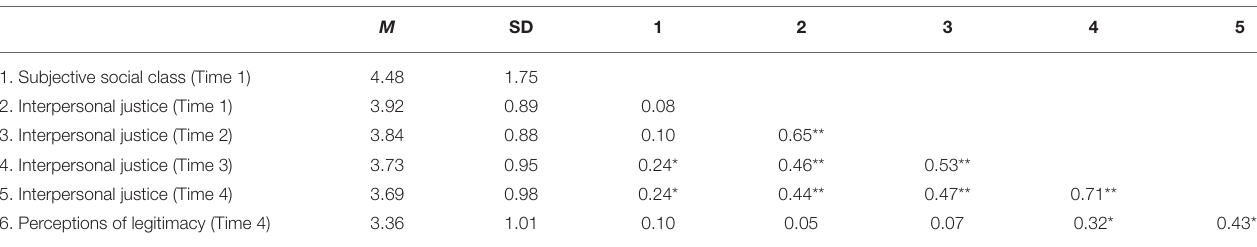
TABLE 2 | Means, standard deviations, and correlation matrix of observed variables.